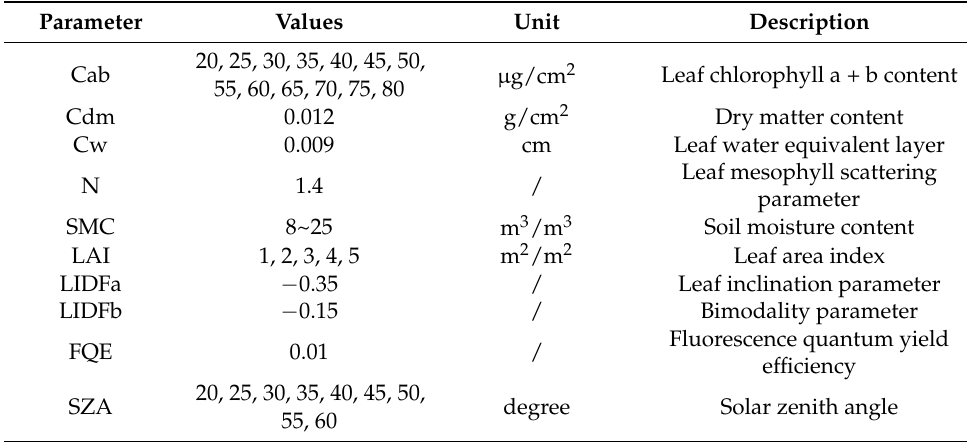
Table 3. Main input parameters for the SCOPE simulations.